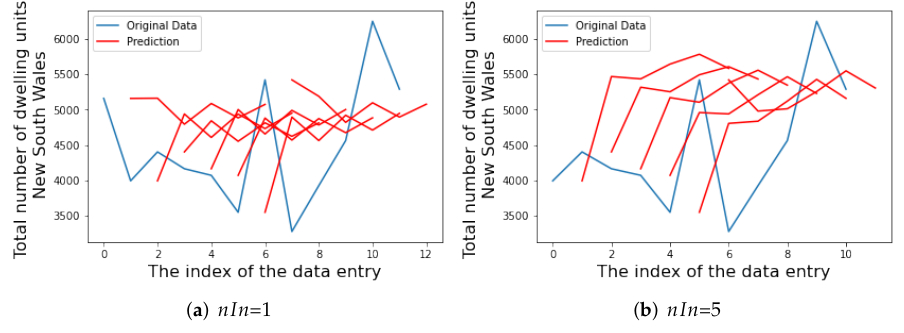
Figure 9. LSTM-based prediction with different nIn